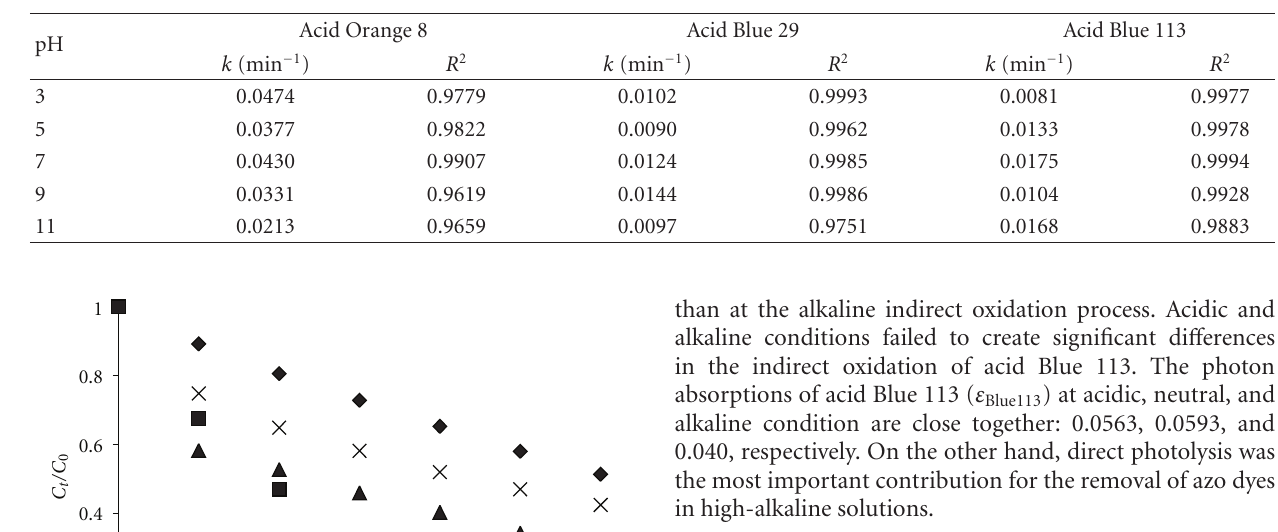
Table 1: k values at di ff erent pH in the degradation of three azo dyes by VUV/H 2 O 2 process.